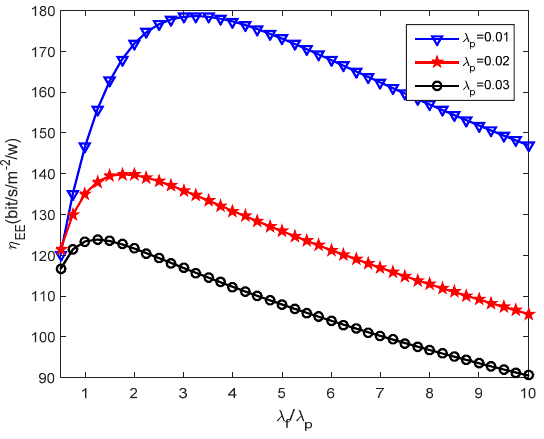
Figure 8. Energy efficiency under different picocell deployment density when T p = 5.5 dB and T f = 1.0 dB.